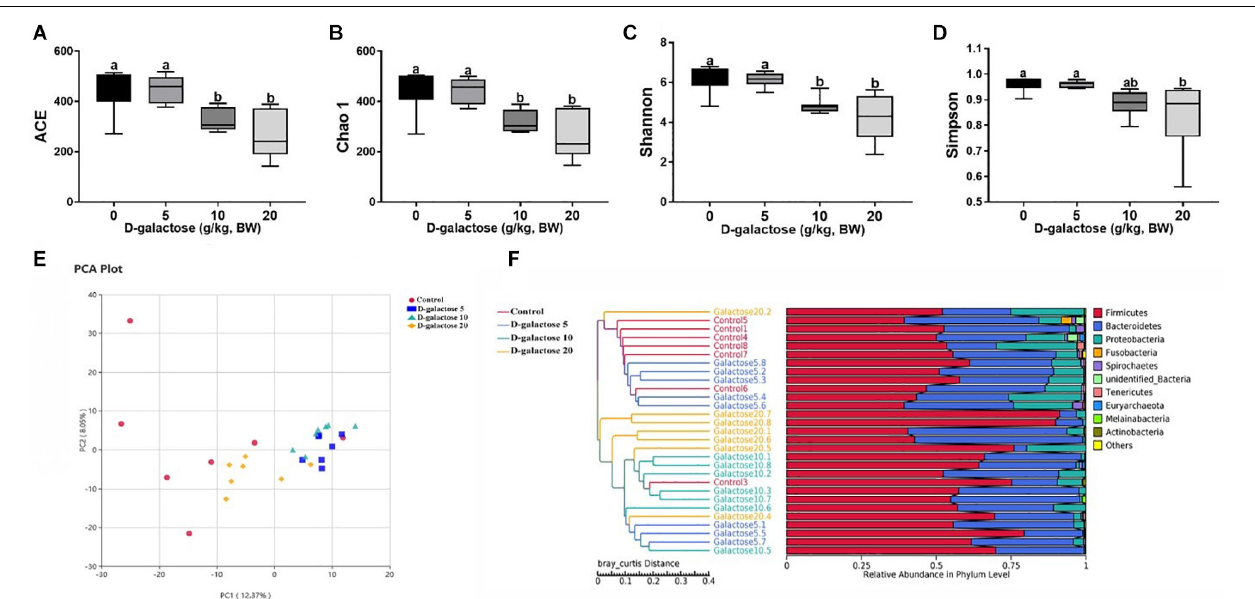
FIGURE 12 | Effects of D -galactose on colonic microbial diversity and unweighted Unifrac distances. (A) ACE index; (B) Chao 1 index; (C) Shannon index; (D) Simpson index; (E) Principal Component Analysis (PCA); (F) Comparison of unweighted Unifrac distances between pairs os samples. Data were expressed as the mean ± SEN. Different lower-case letters indicate a significant difference among different dosage of D -galactose ( P <